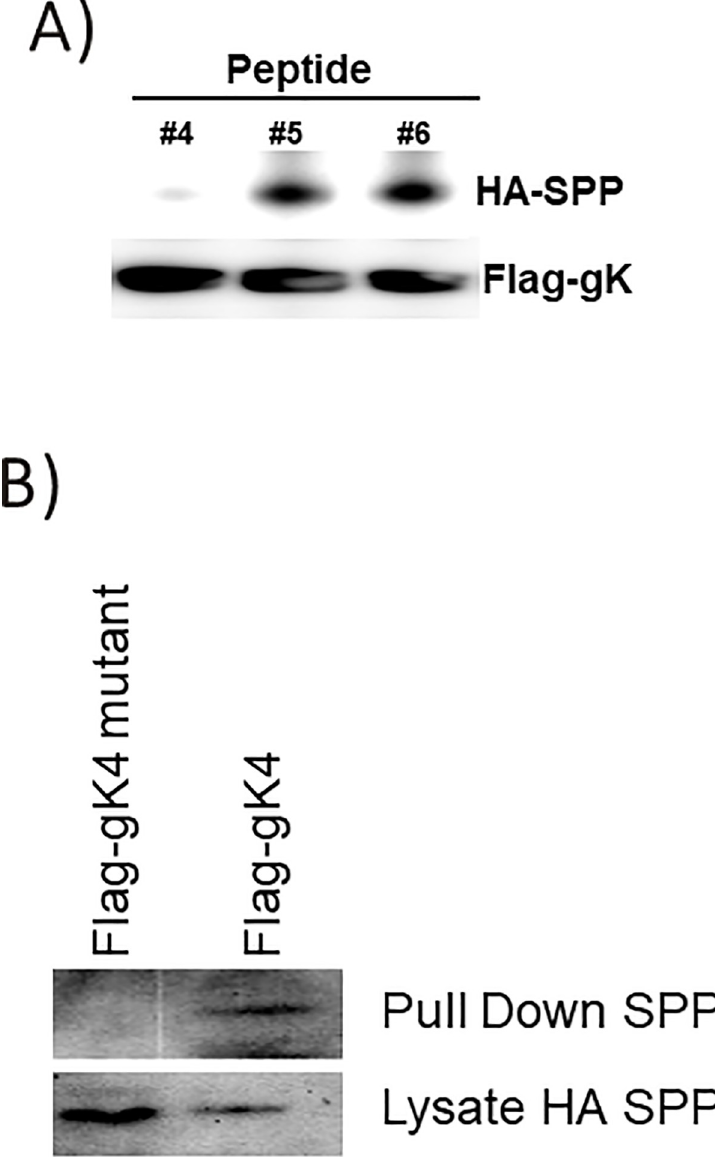
Fig 2. gK4 peptide inhibits the binding of gK protein to SPP protein. A) Blocking gK binding to SPP. HEK293 cells were co-transfected with Flag-gK and HA-SPP plasmids. Cells were harvested 48 hr after transfection. Cell lysate was incubated with the indicated peptide for 2 hr at 4˚C. IP using anti-Flag antibody in the presence of 5 μ g/ml of indicated peptide recovered similar amounts of Flag-gK protein, but significantly less HA-SPP was recovered in the presence of peptide 4. B) Mutated form of gK4 does not precipitate SPP. HEK293 cells were transfected with HA-SPP and Flag-gK or Flag-gK mutant (amino acid RCIYA was mutated to AAAAA). Cell lysates were immunoprecipitated using anti- Flag antibody. The Flag-gK4 mutant failed to pull down HA-SPP, indicating the importance of the mutated region for gK binding to SPP. Panels: A) Mapping gK binding region to SPP; and B) Fine mapping of gK4 binding to SPP. if blocking gK binding to SPP using gK#4 results in reduced HSV-1 replication in vitro . In order to increase penetration of gK#4 peptide into the cell, peptide #4 was fused to HIV Tat on its N-terminus ( YGRKKRRQRRR ASPLHRCIYAVRPTG) to increase penetration into the cell. We also synthesized Tat peptide alone ( YGRKKRRQRRR ) for use as a control. To